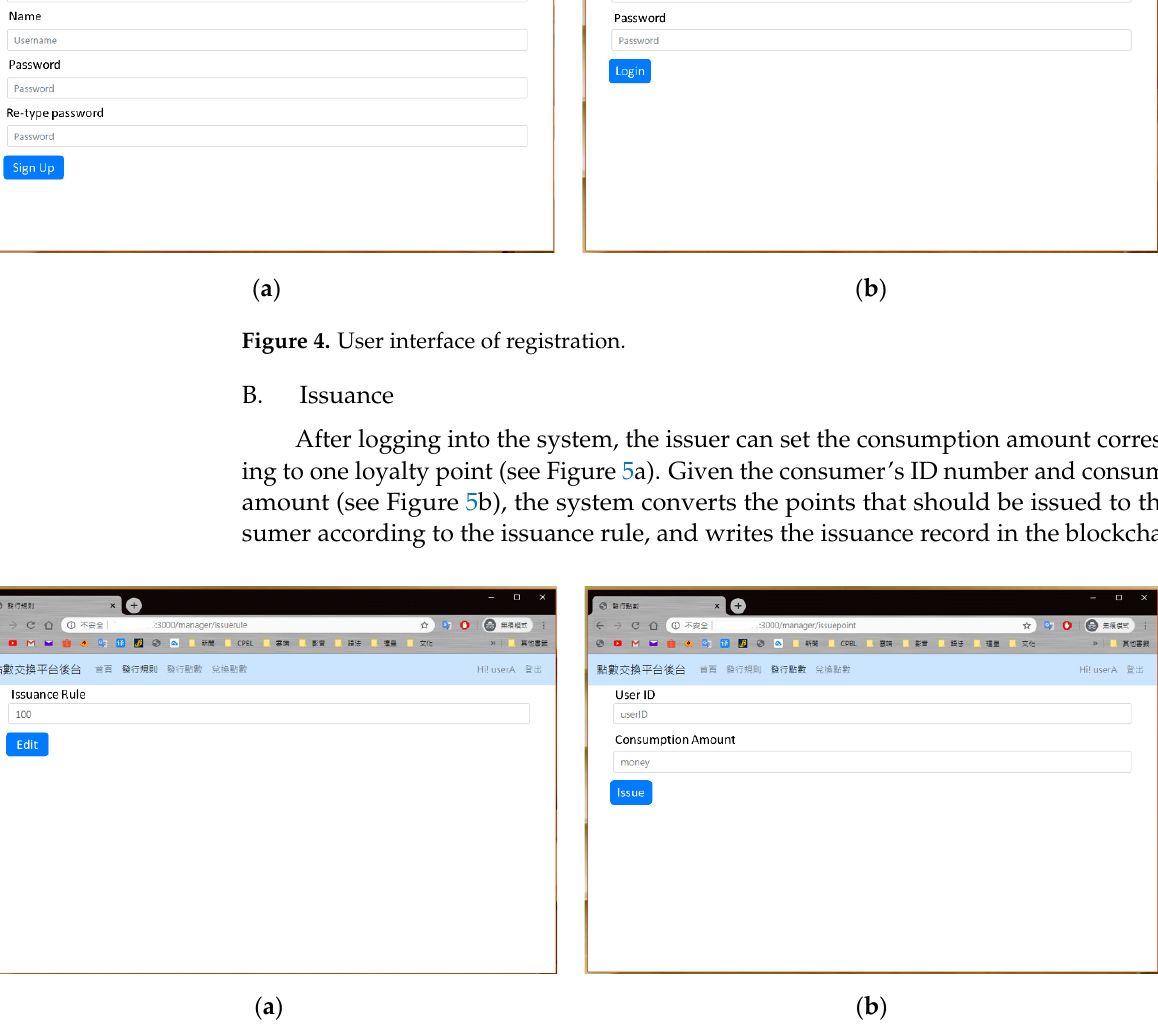
Figure 3. Multi-host deployment of Hyperledger Fabric network.